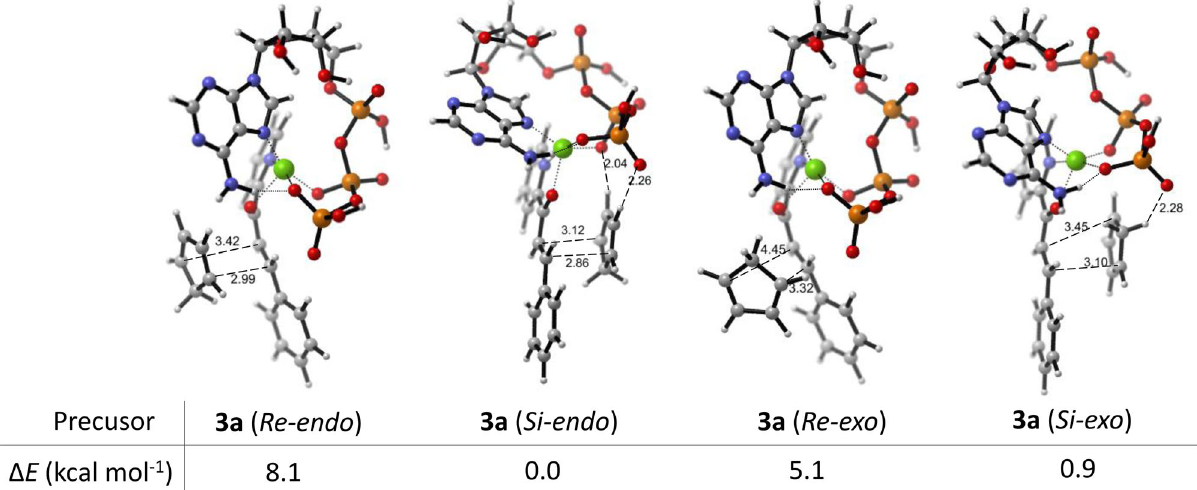
Supplementary Fig. 23. The precursors of the intermediates of 1a -Cu 2 + ⋅ ATP and 2 that yield the corresponding products 3a in different con fi gurations. The relative electronic energies ( Δ E) of the precursors are shown in the table.